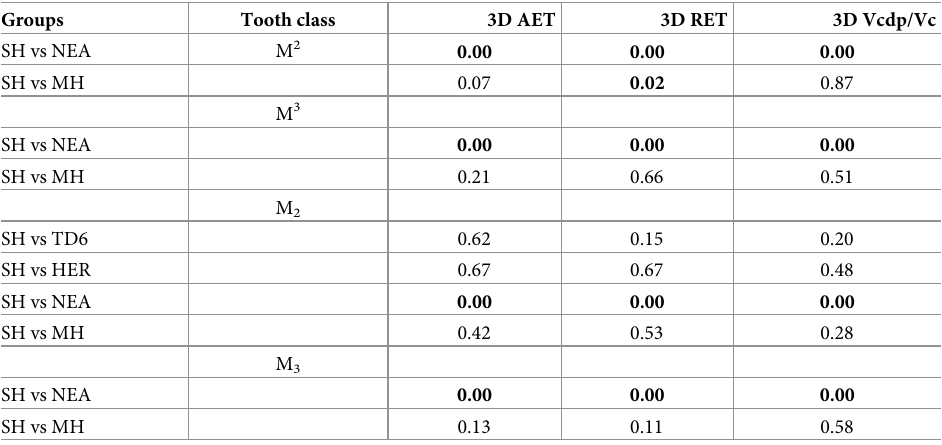
SH vs NEA 0.00 0.00